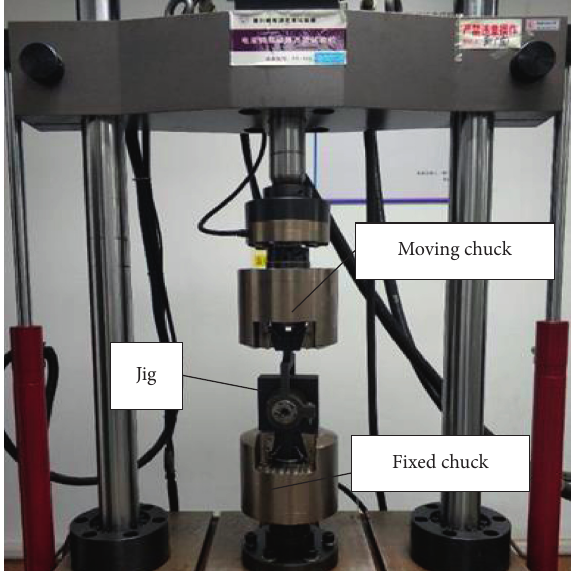
Figure 15: Dynamic test of shaft damping ring.